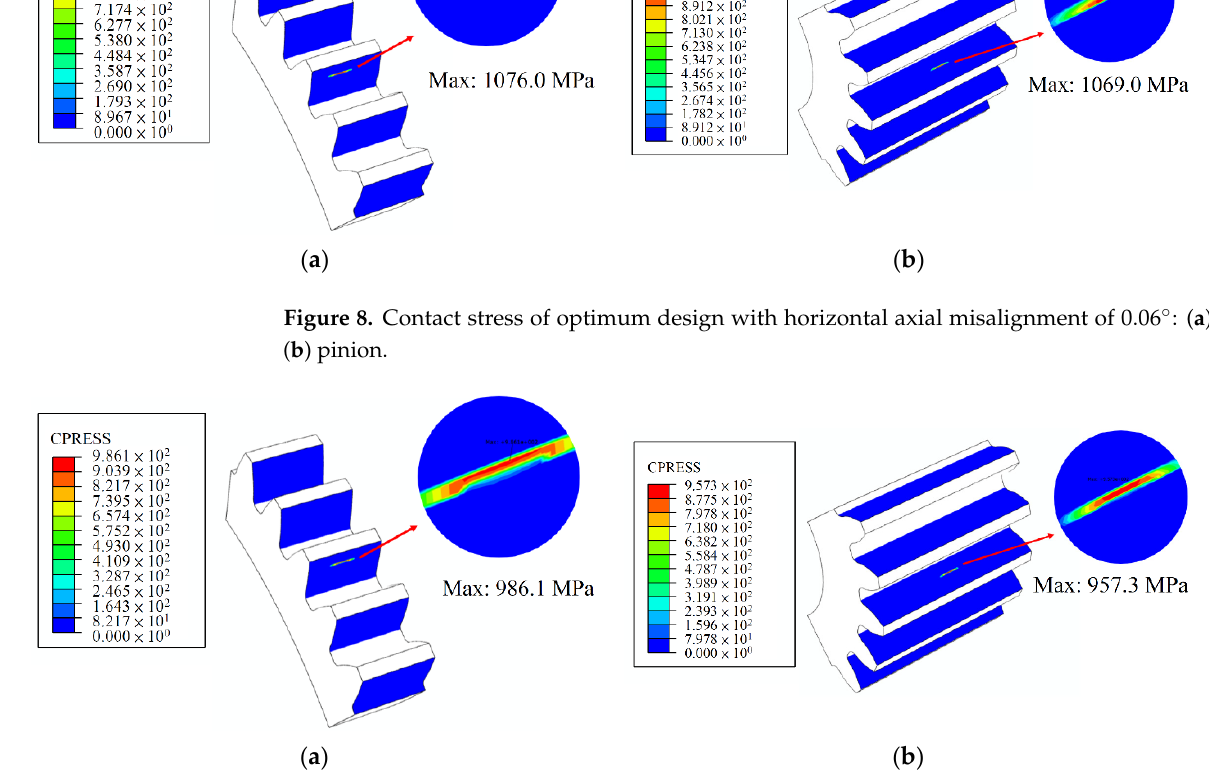
Figure 9. Contact stress of optimum design under vertical axial misalignment of 0.06°: ( a ) gear; ( b ) pinion. ( b )